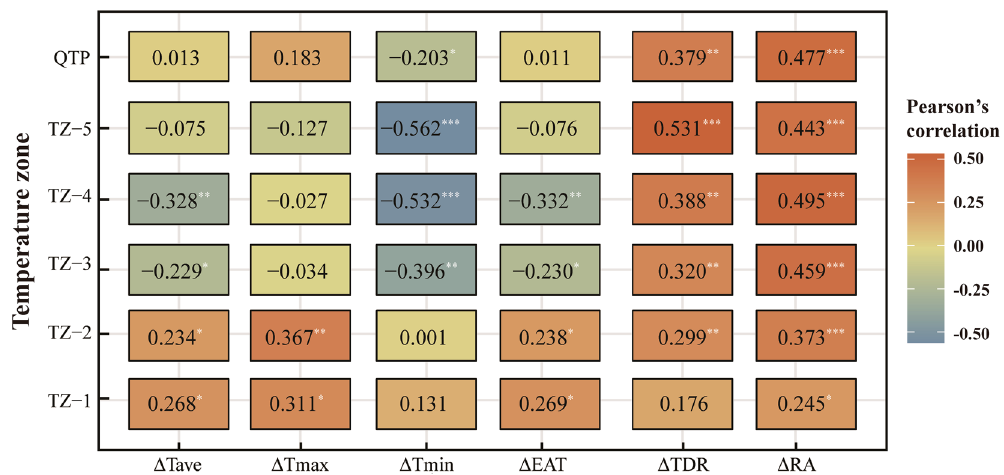
Figure 7. Pearson’s correlation coefficients between highland barley potential yield and climatic factors in different effective accumulated temperature zones and the Qinghai-Tibet Plateau. ΔTave, ΔTmax, ΔTmin, ΔEAT, ΔTDR and ΔRA represent inter-annual changes of average, maximum, minimum temperatures, effective accumulated temperature, temperature diurnal range and solar radiation in the growing season, respectively. *, **and *** indicate significant at 0.1, 0.05 and 0.01 levels, respectively.